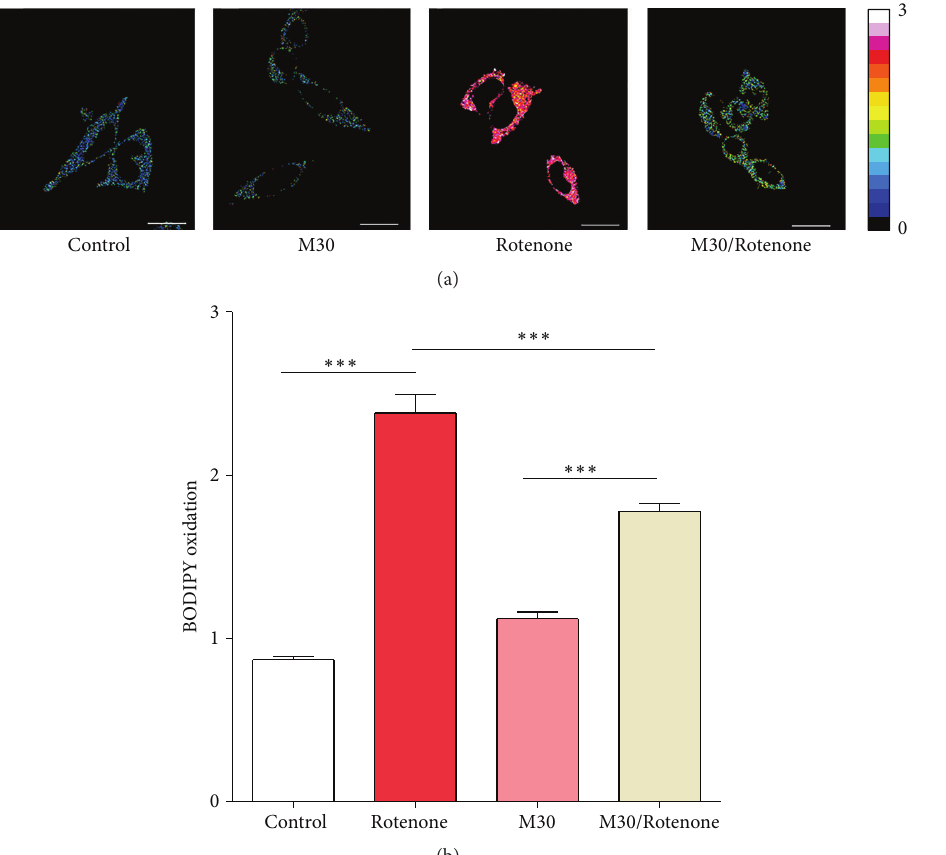
Figure 2: The iron Chelator M30 protect SH-SY5Y cells from rotenone-induce lipid peroxidation. (a) Mitochondrial lipid peroxidation was evaluated by green/red fluorescence changes of C11-BODIPY 581/591 (ThermoFisher Scientific-Molecular Probes) as described [63]. Oxidation of C11-BODIPY 581/591 results in a shift of the fluorescence emission peak from 590 nm (red, nonoxidized) to 510nm (green, oxidized). SH- SY5Y cells were preincubated or not for 24 hours with 500 nM of M30 in DMEM-10% FCS medium and then loaded for 15 minutes at 37 ∘ C with 1 𝜇 M C11-BODIPY 581/591 . Confocal images were obtained 15 minutes both before (Control, M30) and after (Rotenone, M30/Rotenone) applying 80 𝜇 M rotenone to the cells. Representative images are shown, where the ratio of green over (green + red) fluorescence was converted into a pseudothermal scale using the ImageJ program. (b) Changes in C11-BODIPY 581/591 oxidation quantified by the thermal scale. Values represent the mean ± SD of 40–52 individual cell measures per experimental condition. Significance between mean differences was determined by one-way ANOVA and Tukey post hoc test. ∗∗∗ 𝑃 < 0.001